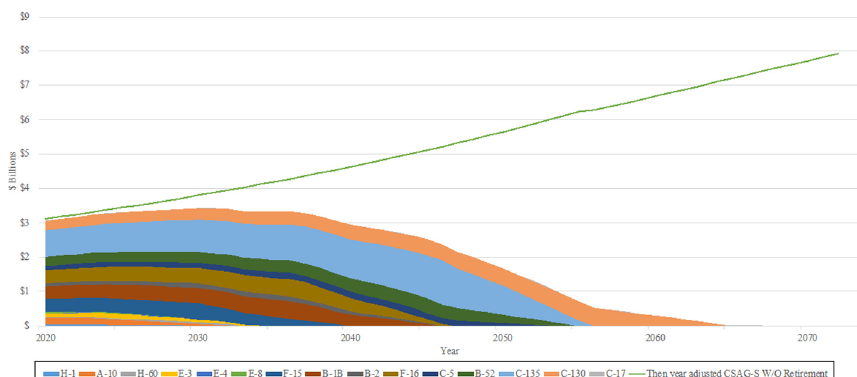
Figure 5. Enterprise level review